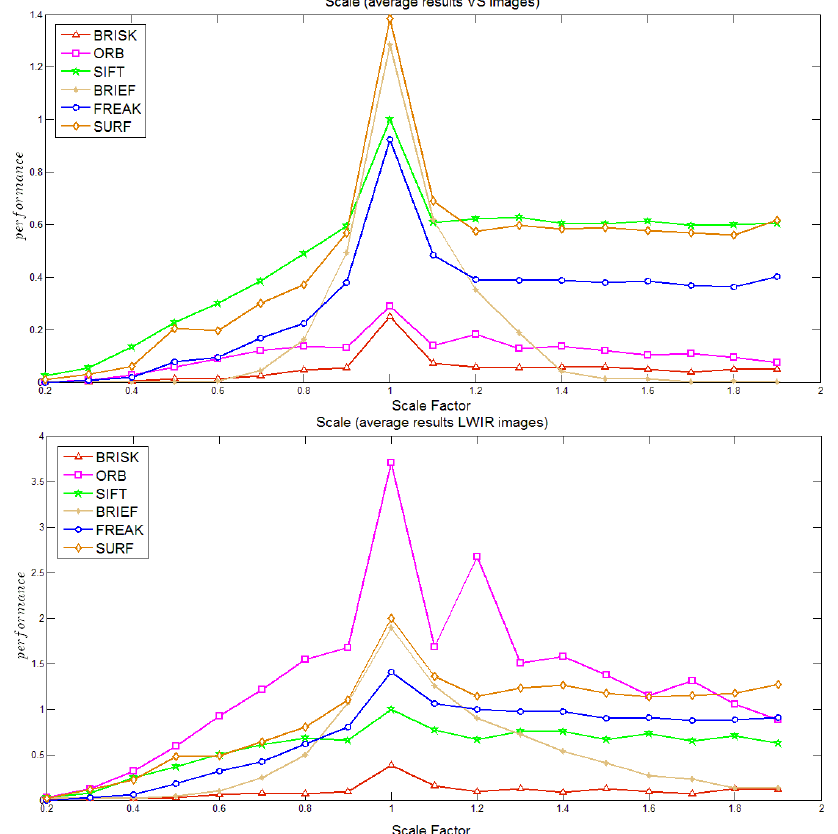
Figure 4. Performance to changes in scale: ( a ) visible spectrum; ( b ) LWIR